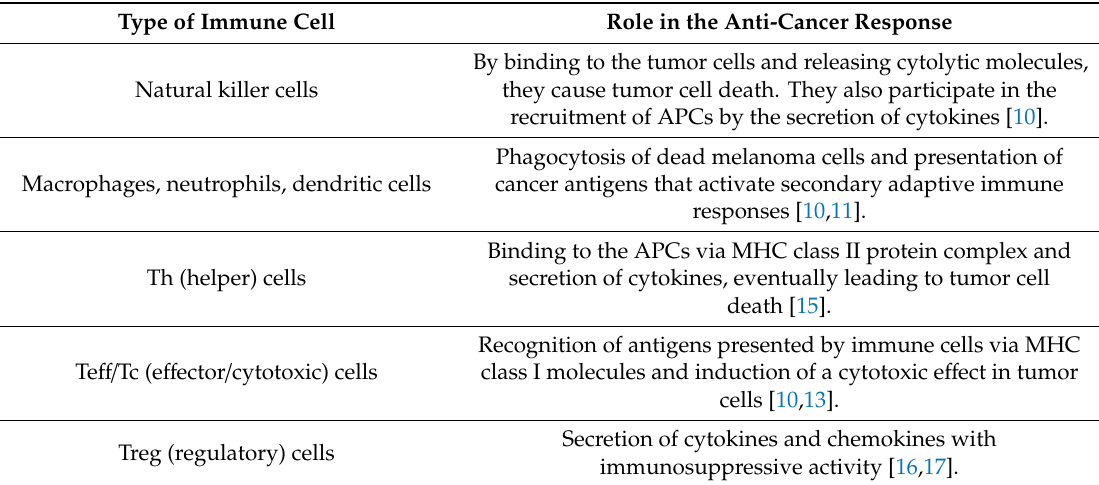
Table 1. Anti-melanoma immune system